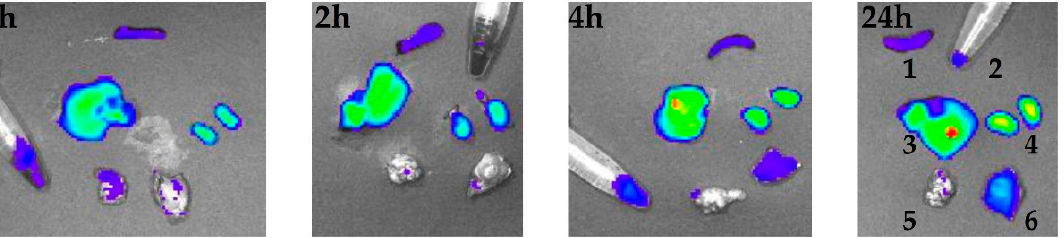
Figure 13. Cy7 fluorescence intensity of the organs and the blood samples of the most representative animal from each time point. Identities: 1—spleen; 2—blood sample in a microtube; 3—liver; 4—kidney; 5—brain; 6—tumour.